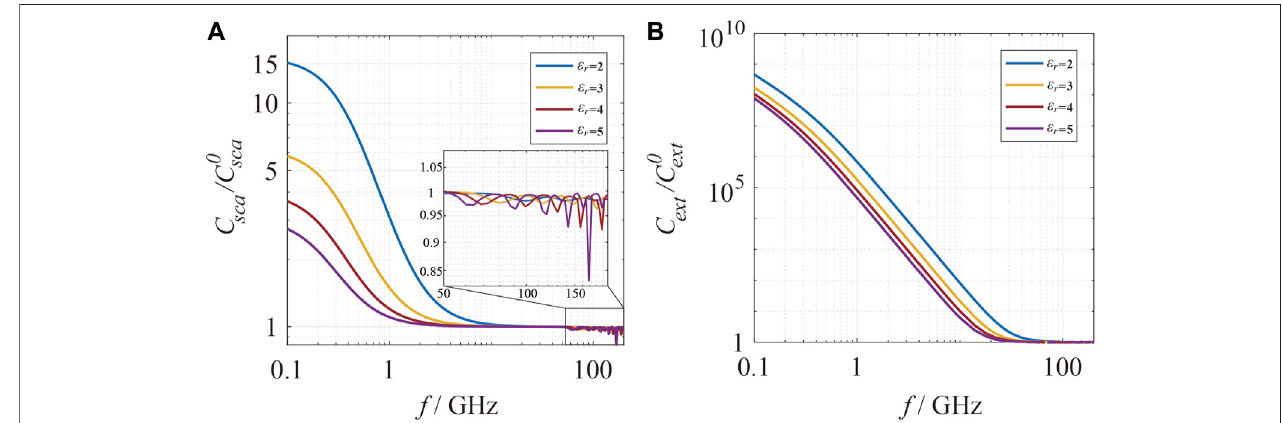
FIGURE 3 | The in fl uence of relative permittivity on the scattering/extinction cross sections of a single charged particle. Relative permittivity is set to ε r (cid:1) 2 , 3 , 4 , 5. (A) The ratio of scattering cross section of a charged particle to that of an uncharged one. (B) The ratio of extinction cross section of a charged particle to that of an uncharged one.